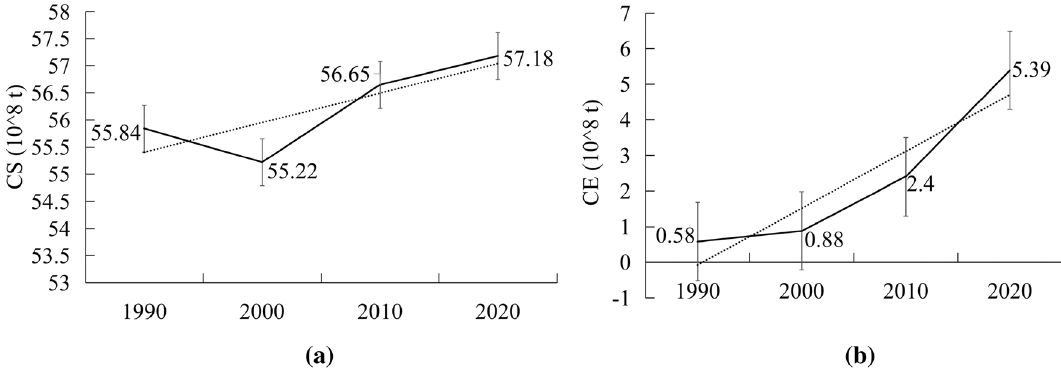
Figure 8. Changes of carbon sequestration ( a ) and carbon emission ( b ) in Xinjiang. Software: Excel 2021. URL: https:// www. micro soft. com/ zh- cn/.